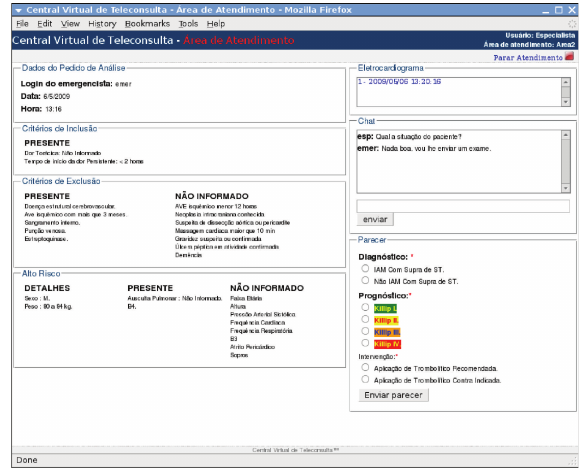
Figure 5: Example of webpage loaded with the patient ECG and clinical information to be assessed by the